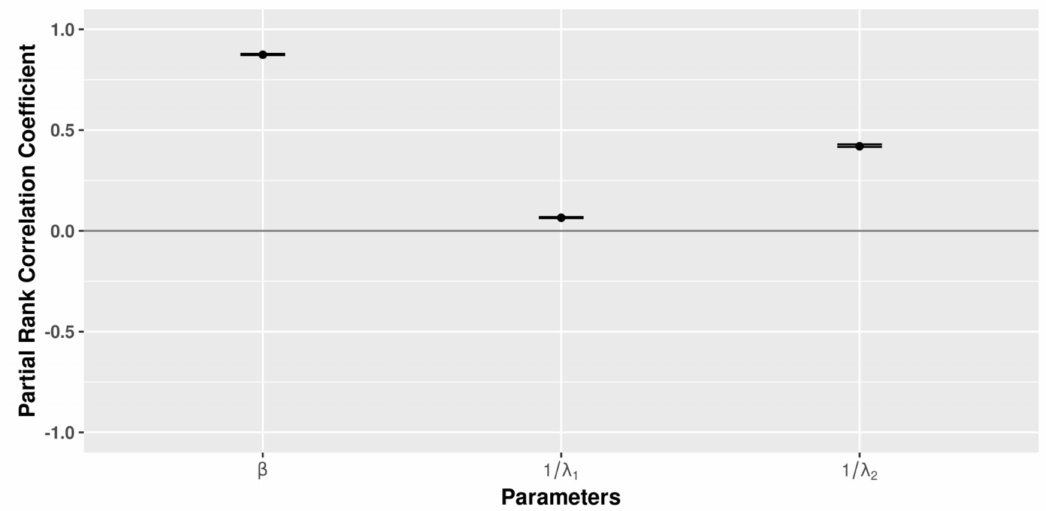
Figure 10. LHS − PRCC global sensitivity results for 1000 samples and 100 replicates for parameters β , 1 PRCC, significantly ( p <